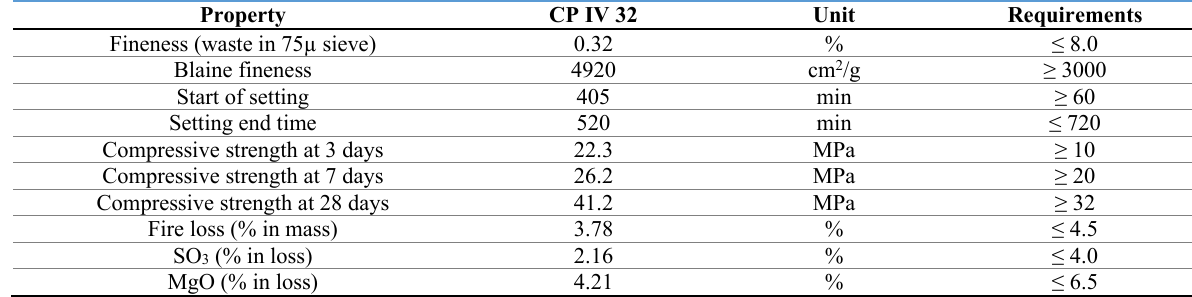
Table 1. Chemical, physical, and mechanical properties of the cement used